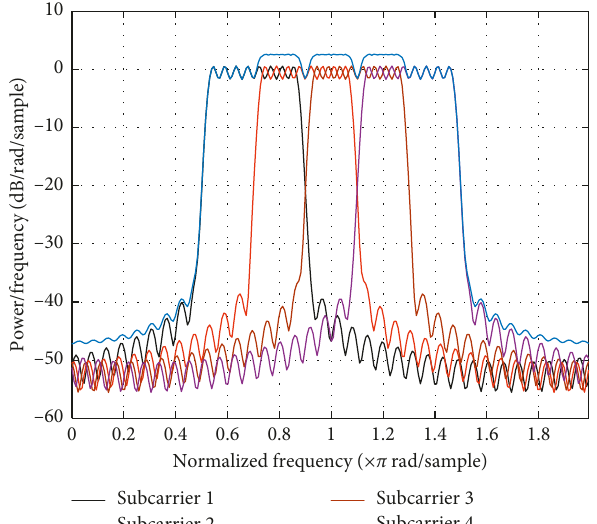
Figure 1: Spectrum of OFDM-LFM with four subcarriers in which sub-bands are four square waves that are orthogonal to each other.